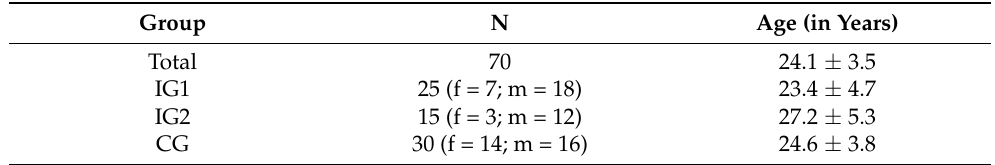
Table 1. Characteristics of